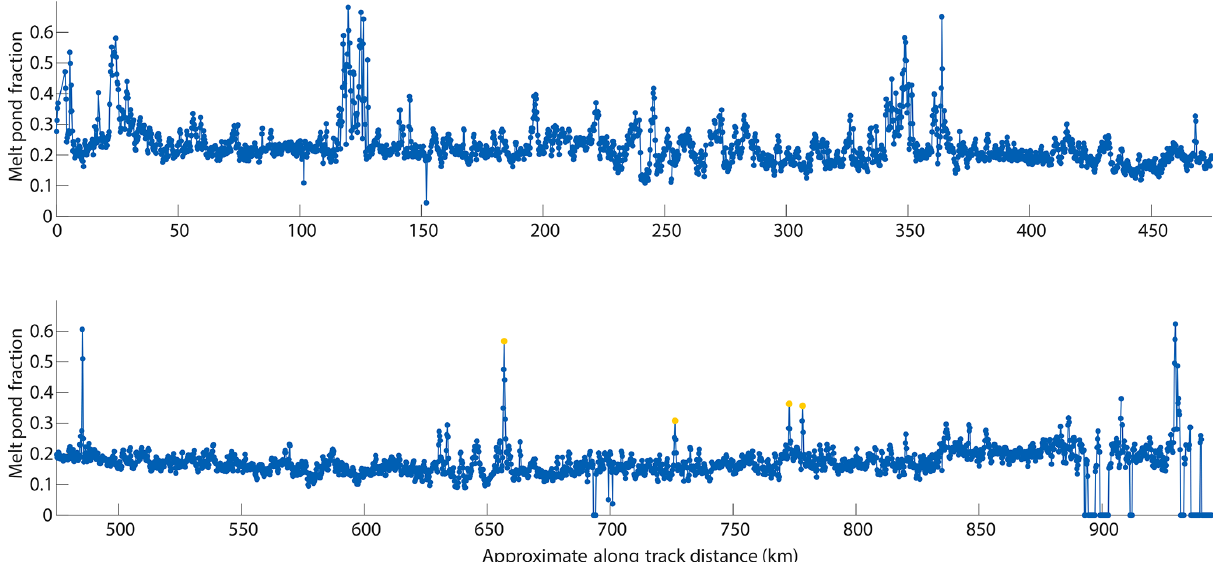
Figure 5. Melt pond fraction along track for flight 24 July 2017. The four orange highlighted points represent areas where there was a large blue pond on the multiyear ice that occupied a large fraction of the image. See Fig. 11d for an example of this feature.